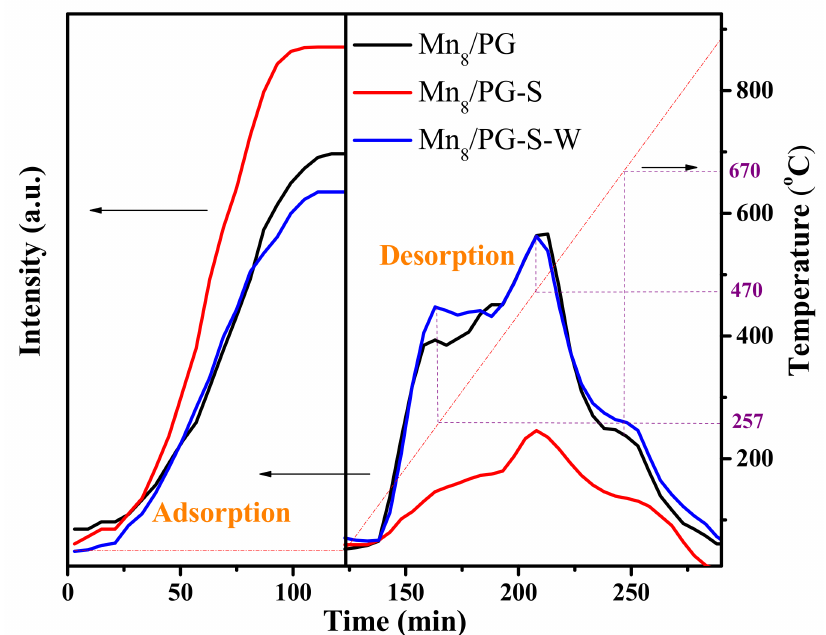
Figure 10. The NH 3 emission profiles of isothermal adsorption and following temperature- programmed desorption (TPD). Reaction conditions: 0.5 g of the catalyst, 600 ppm of NO, GHSV = 16,000 h − 1